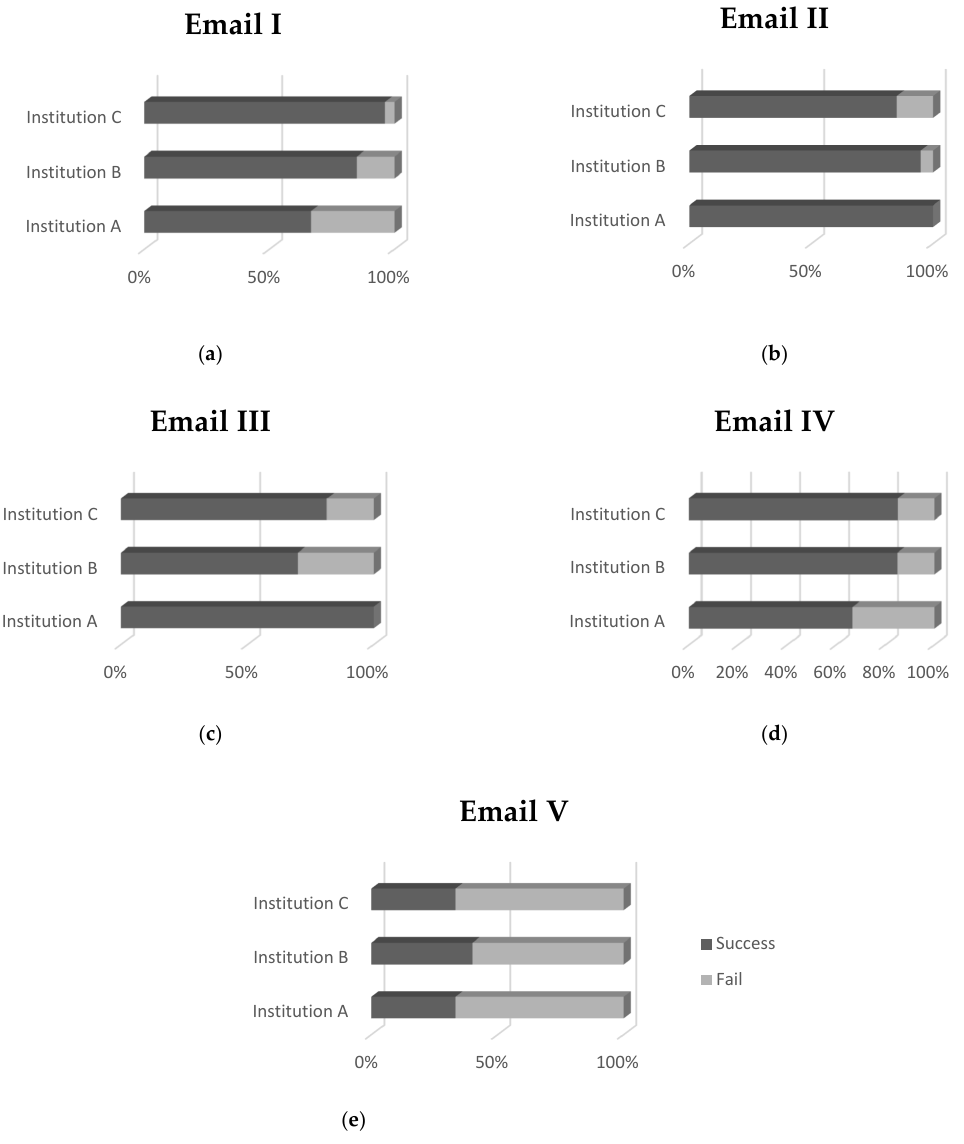
Figure 7. Campaign assessment results per hospital for: ( a ) email I, ( b ) email II, ( c ) email III, ( d ) email IV and ( e ) email V, of the phishing quiz.